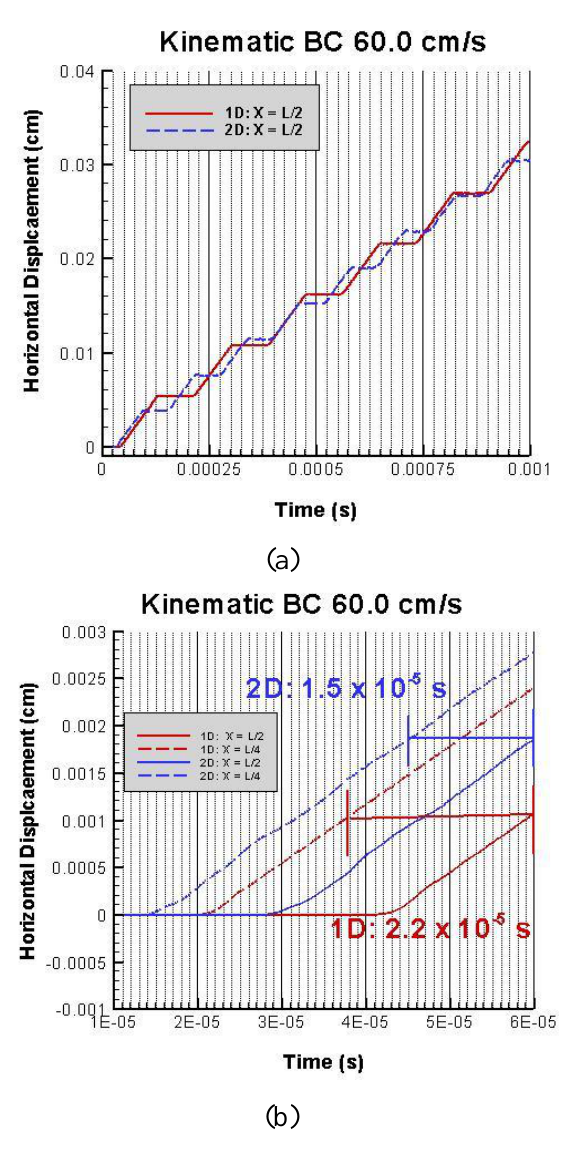
Figure 16. HPLM prediction of horizontal displacement for 1D and 2D bar, respectively. (a) horizontal displacement recorded at X = L/ 2; (b) horizontal displacement recorded at X = L/ 4 and X = L/ 2. Kinematic boundary condition is applied